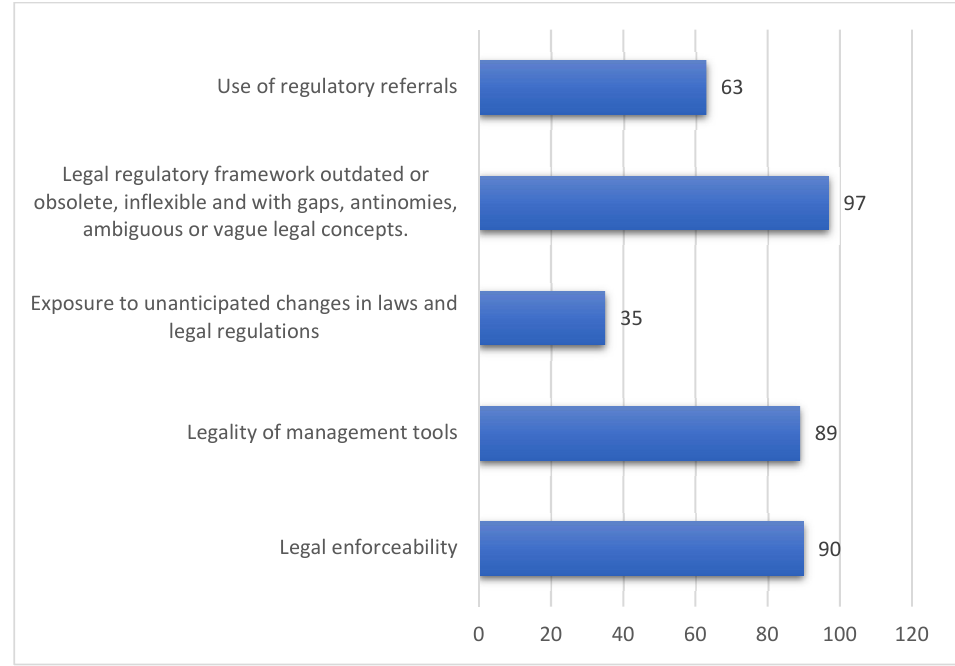
Figure 3. Levels of incidence of demonstrations according to interviewees.